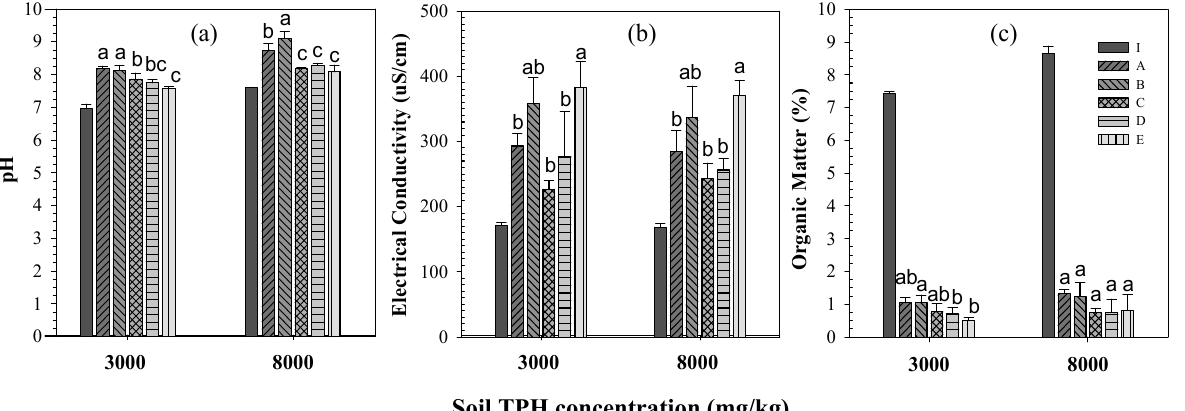
Figure 1. Changes in soil properties before and after bioremediation experiments. ( a ) for pH; ( b ) for electrical conductivity; ( c ) for organic matter. “I” stands for the initial condition before testing. “A”: used the native bacteria; “B”: added the petroleum-decomposing bacteria; “C”: planted V. zizanioides ; “D”: added A. venetianus bacteria and planted V. zizanioides ; “E”: 2.5% biochar was added to the soil and planted V. zizanioides . Identical lowercase letters on bar indicate statistically insignificant differences; differences indicate significant differences.